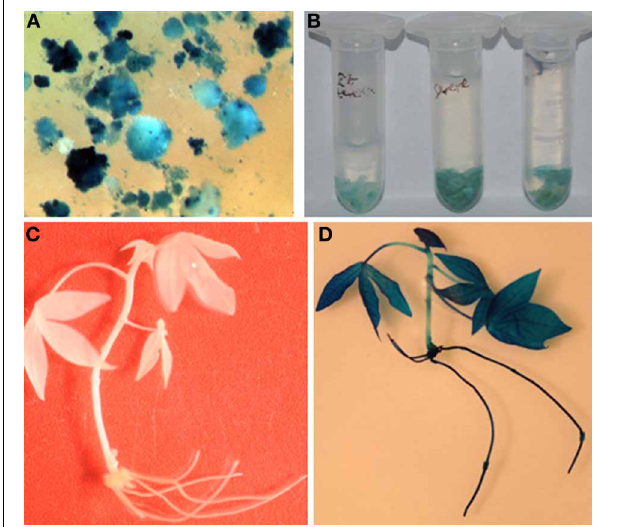
FIGURE 3 | Transient and stable expression of GUS in co-cultivated calli and hygromycin-resistant transformants. (A) transient GUS expression after 3 days of co-cultivation; (B) stable GUS expression in somatic embryos of Ebwanatereka (left), Serere (middle) and cultivar 60444 (right); (C) no GUS expression in non-transgenic control plant; (D) stable expression of the GUS gene in transgenic Serere plantlet.